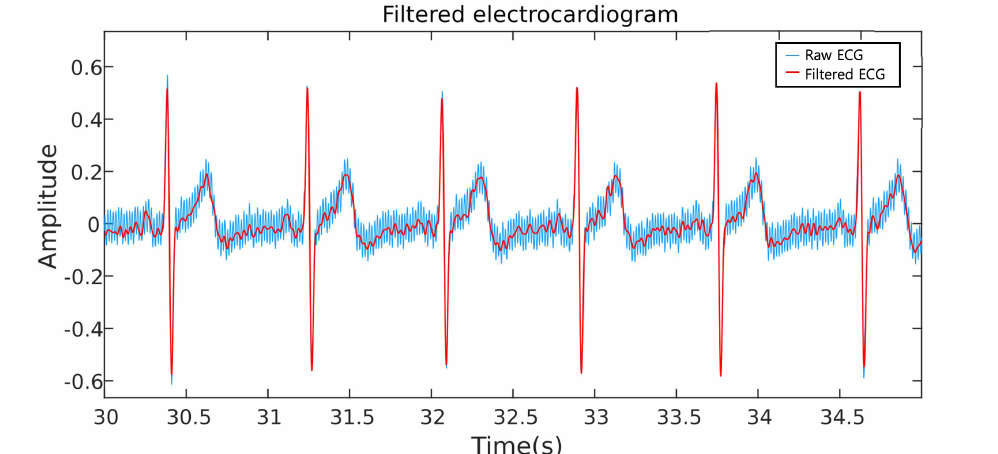
Figure 3. Noise − canceled electrocardiogram (ECG) signal using an FIR filter. Note that the noisy com- ponents in the raw ECG signal (in blue color) are attenuated to derive the actual signal (in red